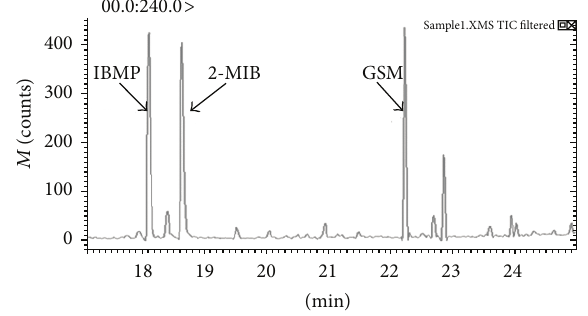
Figure 1: To identify the two odors and the internal standard compound by